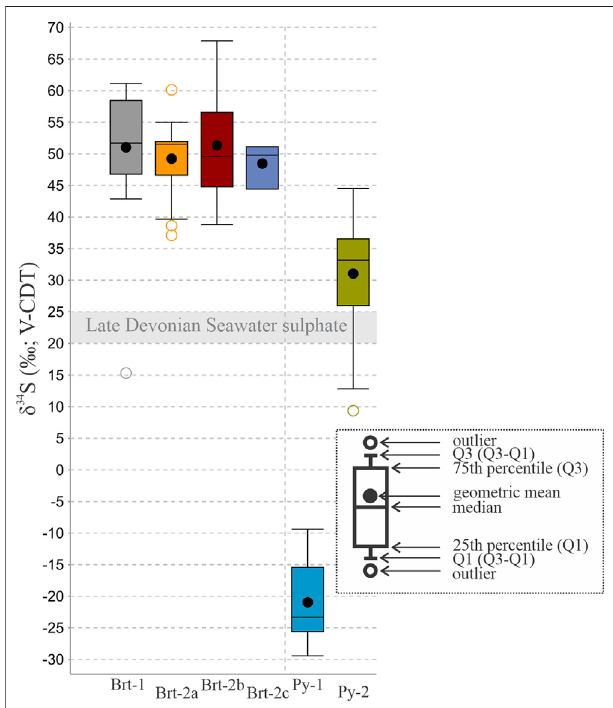
FIGURE 11 | Box and whisker plot of barite and pyrite δ 34 S value from this study. Grey area indicates the extent of Late Devonian seawater (John et al., 2010). The colors are intended as visual aids, highlighting the barite and pyrite types.